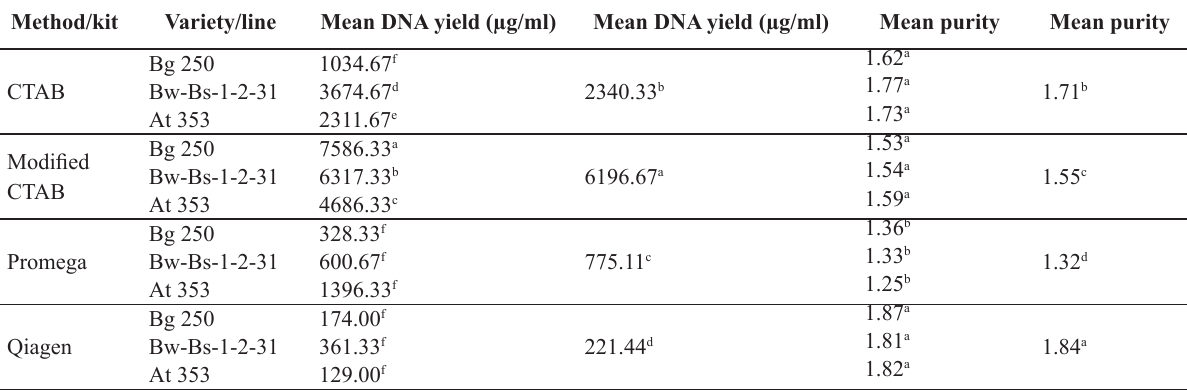
Table 2: DNA yield and purity of the samples extracted using four different methods/kits.